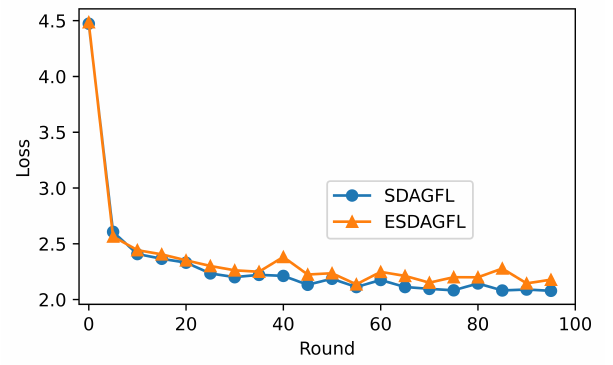
Figure 6. The average training loss of ESDAGFL and SDAGFL evaluated on the Poets